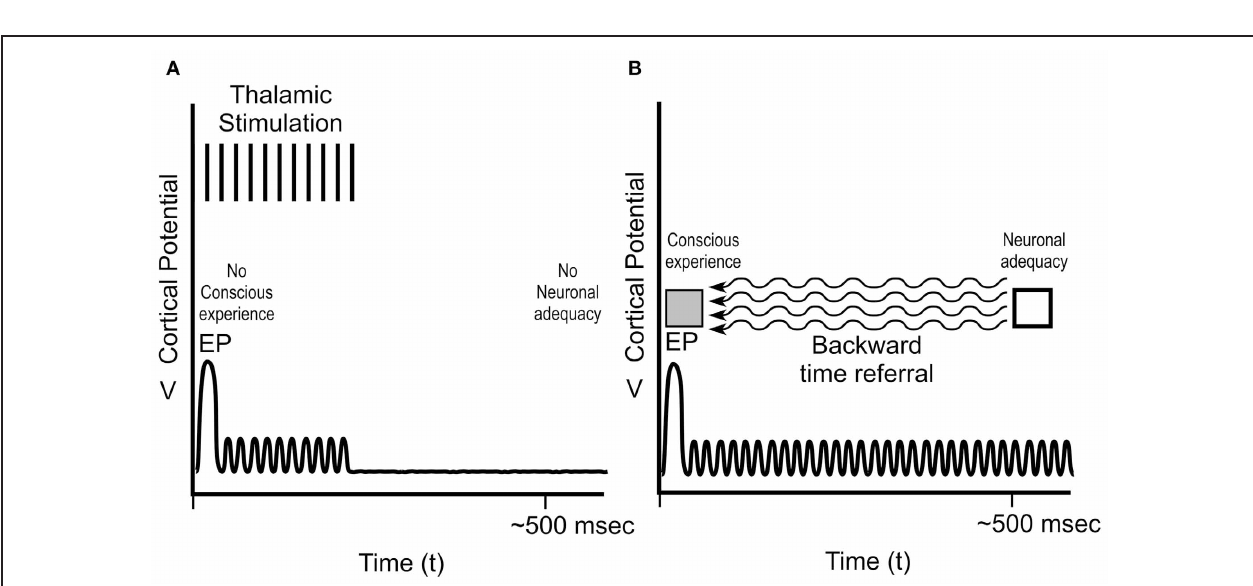
FIGURE 8 | Cortical potentials in Libet’s sensory experiments. (A) Peripheral stimulation, e.g., at the hand, results in near-immediate conscious experience of the stimulation, an evoked potential EP at ∼ 30ms in the “hand area” of somatosensory cortex, and several 100ms of ongoing cortical electrical activity. (B) Direct cortical